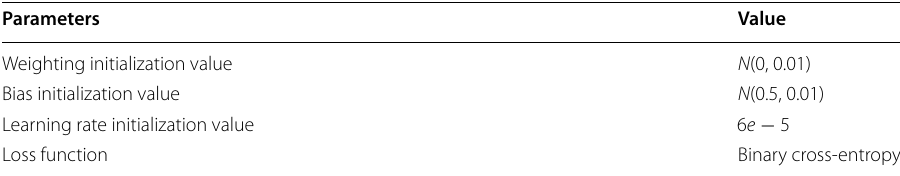
Table 1 Training parameters of the Siamese network Parameters Value